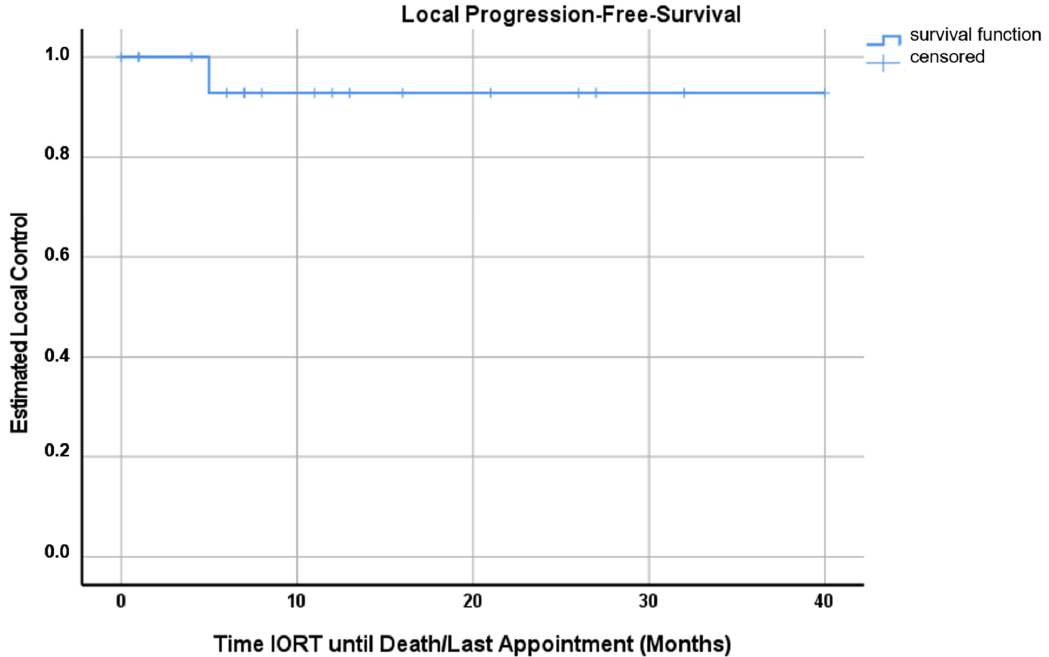
Figure 2. Kaplan–Meyer curve for local progression-free survival censoring local recurrence. For all 18 patients reviewed in this analysis, the estimated local control was 92.9% (95% ‐ CI 79.3–100%).